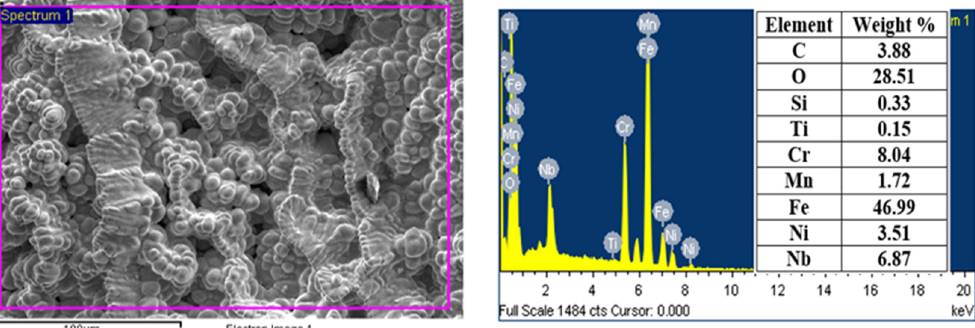
Figure 14. EDS spectral analysis in the lateral solidification hot cracking face in TIG weld coated by the mixture of powders (80% Nb + 20% Ti).